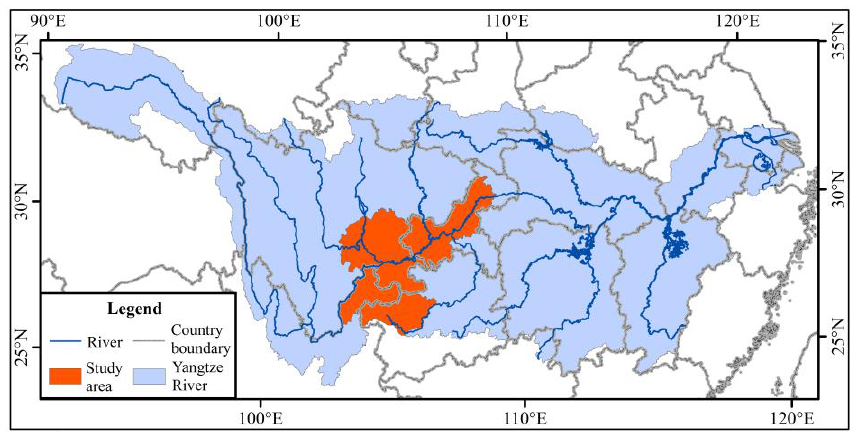
Figure 1. The location of the study area in the Yangtze River Basin.